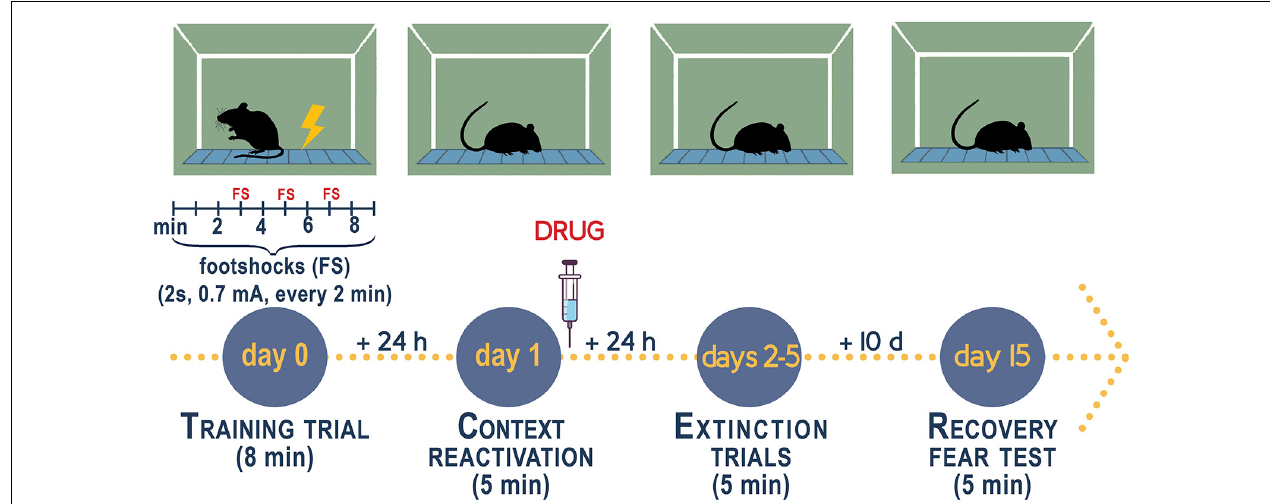
FIGURE 2 | Experimental procedure to measure fear conditioning responses, fear extinction, and fear extinction retention in socially isolated mice. Contextual fear conditioning responses in socially isolated is studied after 4 weeks of isolation when the decline of allopregnanolone is maximal (Pibiri et al., 2008; Pinna et al., 2008). Group-housed mice of the same age as the socially isolated mice serve as control. Socially isolated mice express a decrease of corticolimbic allopregnanolone levels that is associated with an enhancement of contextual fear responses and impaired fear extinction (Pibiri et al., 2008). The fear-conditioning apparatus, which schematized in the figure, consists of a transparent acrylic chamber measuring 25 cm wide, 18 cm high, and 21 cm deep (San Diego Instruments). The cage floor is composed of stainless-steel rods connected to an electric shock generator. A small fan is located on the top wall of the enclosure. The chamber is surrounded by a frame with 16 infrared photo beams. A computer controls the delivery of electric foot shocks and auditory stimuli and records beam interruptions and latencies to beam interruptions (freezing time). Training Test . During the training, mice are placed into the training chamber and allowed to explore it for 2 min. After this time, they receive an unconditioned stimulus (US, electric footshock, 2 s, 0.5 mA). The footshock is repeated three times every 2 min. After the last tone plus shock delivery, mice are allowed to explore the context for an additional minute before removal from the training chamber (total of 8 min). Contextual Test . Twenty-four hours after training, the mice are placed in the contextual cage, and freezing behavior is measured for 5 min (Freeze Monitor System, San Diego Instruments) without footshock presentation. Extinction Test . For contextual extinction experiments, mice are placed in the contextual cage for 5 consecutive days starting 24 h after the training session. Fear extinction retention . Retention of fear extinction is measured by placing the mice to the context for 5 min following an interval of 10 days. Freezing behavior is measured for 5 min without tone or footshock presentation. Freezing is defined by the absence of any movement except for those related to respiration while the animal is in a stereotypical crouching posture (Pibiri et al., 2008). To disrupt aversive memories through a reconsolidation blockade (Stern et al., 2012), drugs are given immediately after a contextual fear conditioning reactivation session (Pinna and Rasmusson, 2014; Locci and Pinna,